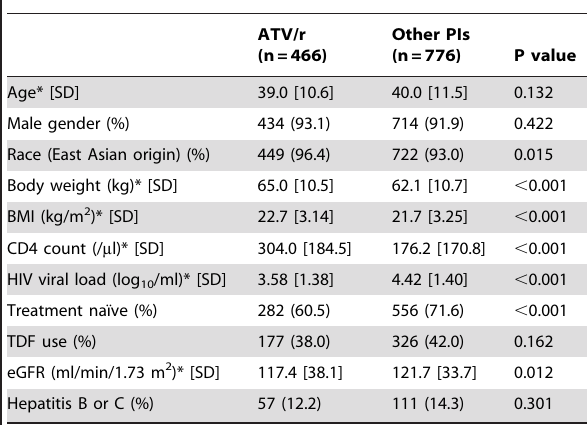
Table 1. Baseline demographics and laboratory data of patients who received ATV/r- and other-PIs-containing antiretroviral therapy